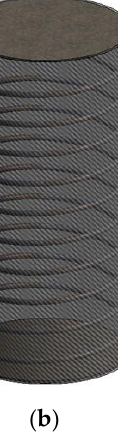
Figure 2. Three-dimensional schematic diagrams of specimen structures with different cross-section shapes: ( a ) square with rounded corners specimens; ( b ) circular specimens. Table 1. Summary of test results.